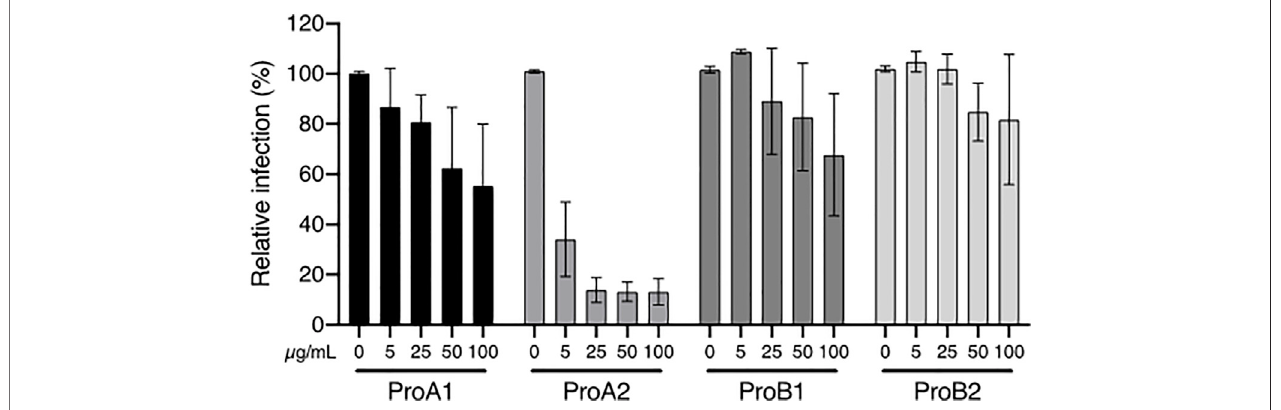
FIGURE 6 | Anti-HCV activity of procyanidins. Huh-7 cells were inoculated with HCV in the presence of procyanidin A1 (ProA1), A2 (ProA2), B1 (ProB1), and B2 (ProB2)at5,25,50and100 µM.Cellswere fi xed30 hpost-infection.Quanti fi cationofinfectionwasasdescribedabove.Dataarepresentedrelativetountreatedcontrol and are means ± SEM of 3 experiments performed in